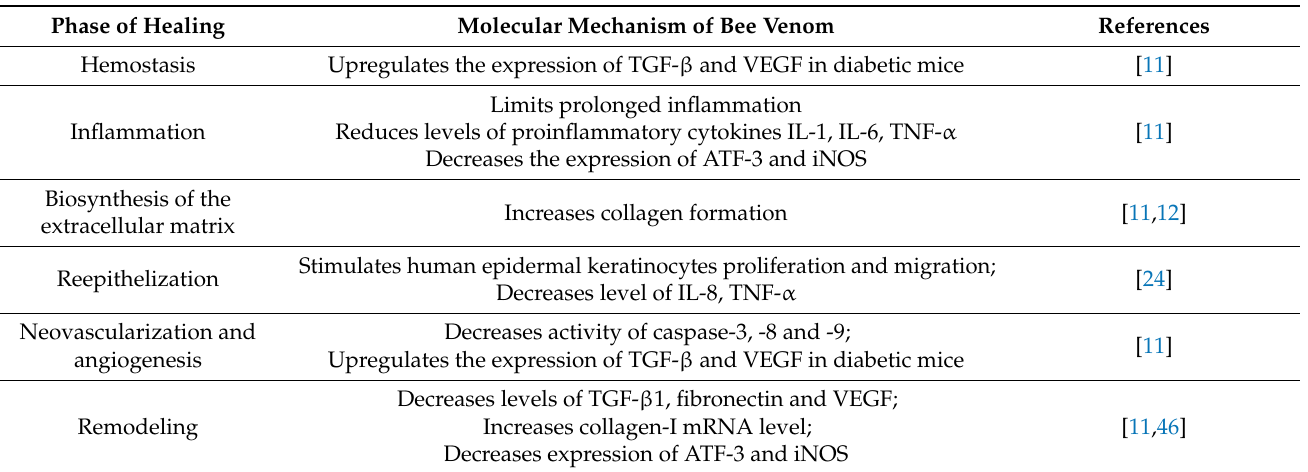
Table 2. Molecular mechanisms of bee venom on skin wound healing